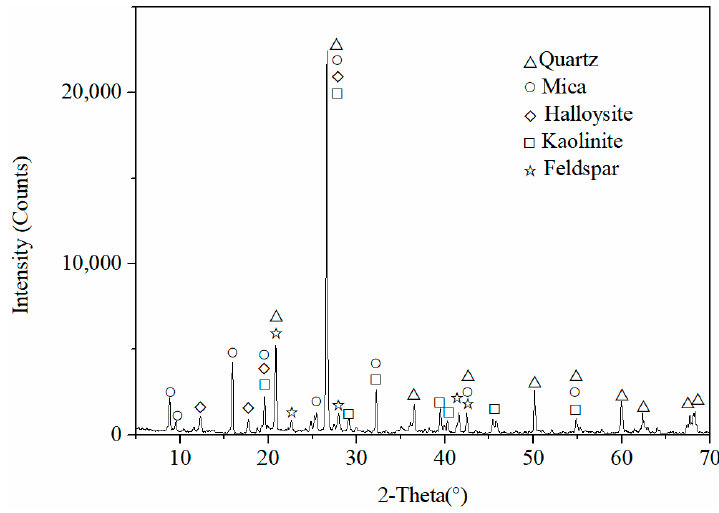
Figure 1. The X-ray diffraction (XRD) of the rare earth ore.